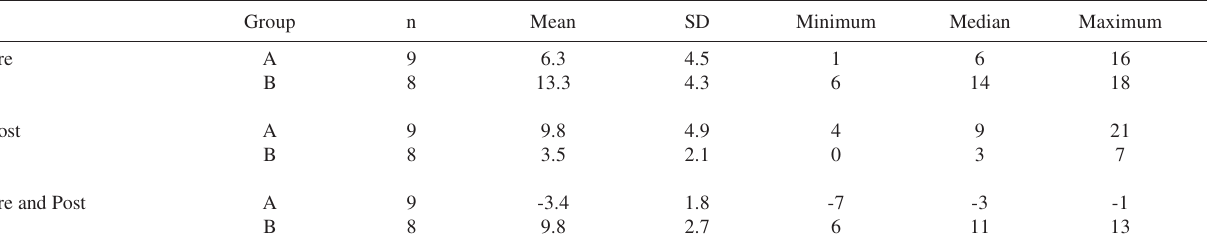
Table 4 - Descriptive statistics for the degree of hip joint dysfunction in pre- and posttreatment periods and for the difference between periods, in groups A and